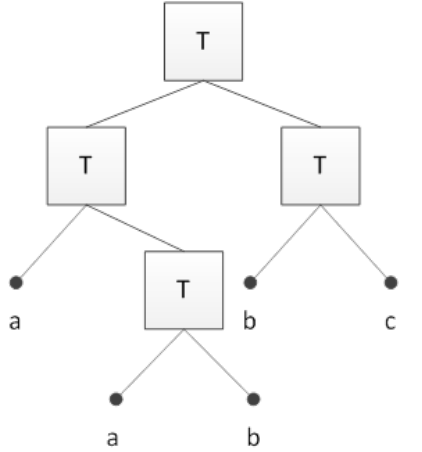
Figure 2. Principle of decision tree classification (T=test using thresholds of attributes; a, b, c=classes). Modified after (Friedl and Brodley, 1997)